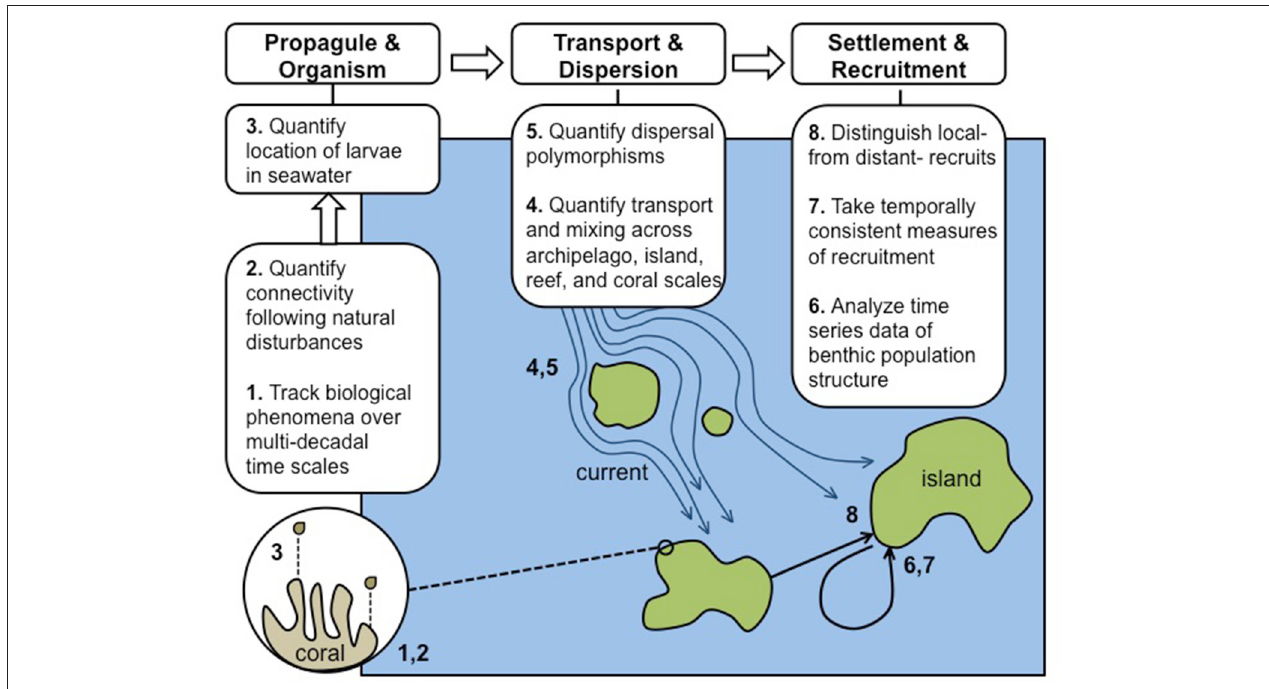
FIGURE 1 | Schematic of eight domains (described in the text with corresponding 1–8) requiring integration, concurrent research, and further quantitative data to allow CRI to achieve their full potential in advancing understanding of the role of connectivity in coral reef resilience. The needs for integration and additional data are divided into three categories underscoring the chronology of biological events beginning with reproduction and ending with recruitment, as exemplified by scleractinian corals: responses at propagule and organism levels, pelagic larval transport processes, and analysis of post-settlement and recruitment